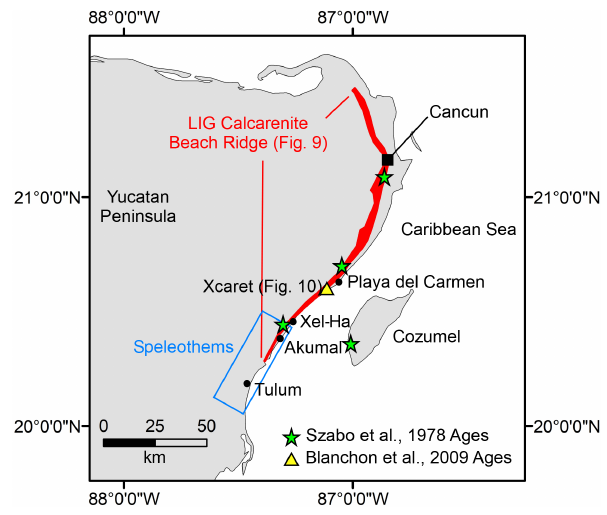
Figure 8. Map showing the location of LIG shoreline features of the Mexican Yucatán Peninsula. The red strip is the location of the LIG calcarenite beach ridge as mapped by Ward and Brady (1979), the green stars are the locations of the U-series ages collected by Szabo et al. (1978), and the yellow triangle is the location of the Blanchon et al. (2009) study. Also shown as a blue box is the general location of the speleothems studied by Mosey et al.